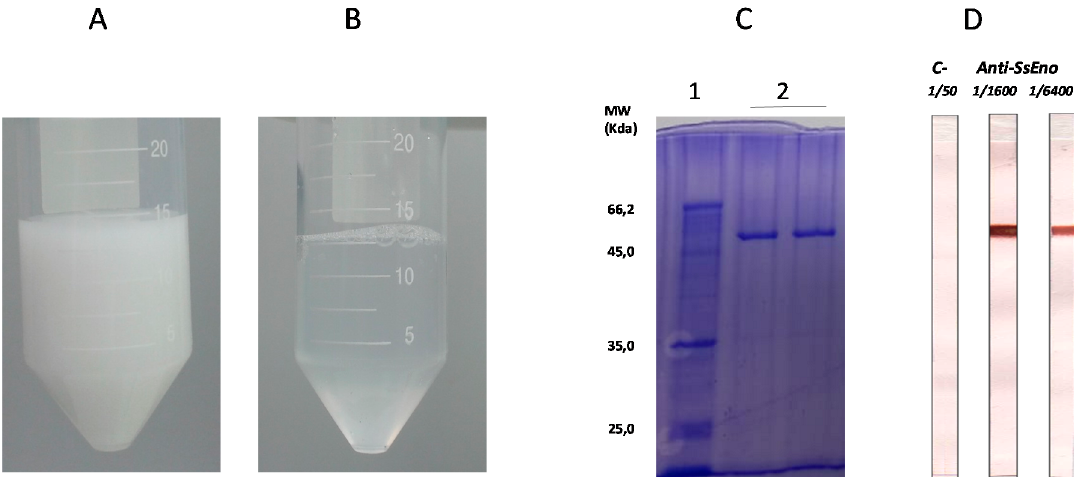
Figure 1. External aspect of ( A ) Montanide TM PetGel (PGA) and ( B ) PGA+rSsEno vaccine formulation. ( C ) SDS-PAGE showing the expression and purification of rSsEno. C1. Molecular pattern, C2. rSsEno band stained with Coomassie blue with the expected 47 kDa molecular mass (in duplicate). ( D ) Immunoblotting analysis of rSsEno with a pooled anti- rSsEno serum from Balb/c mice immunized with Freund’s adjuvant/rSsEno (Either 1/1600 or 1/6400 dilutions of serum were used). A pooled serum from non-immunized mice (dilution 1/50) was used as negative control (C − ) to identify non-specific binding.